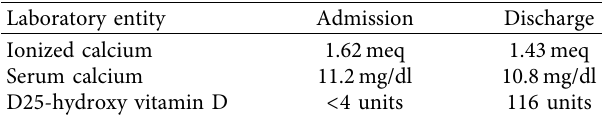
Table 3: Laboratory results of calcium and vitamin-D on admission and